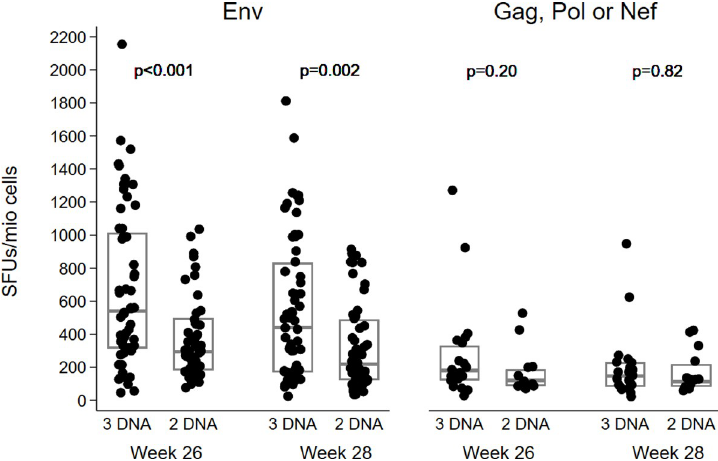
Fig 3. Magnitude of T-cell responses in vaccine groups at the primary end points (weeks 26/28) measured by IFN- γ ELISPOT assay, EV03/ANRS VAC20 Phase I/II Trial. Individual magnitude (SFC/10 6 PBMC) of vaccine-induced T cell responses against Env (left panel) or Gag, Pol, and Nef (right panel) in the two study groups at weeks 26 and 28. Boxes represent median values with IQR. Comparisons between groups were made using rank